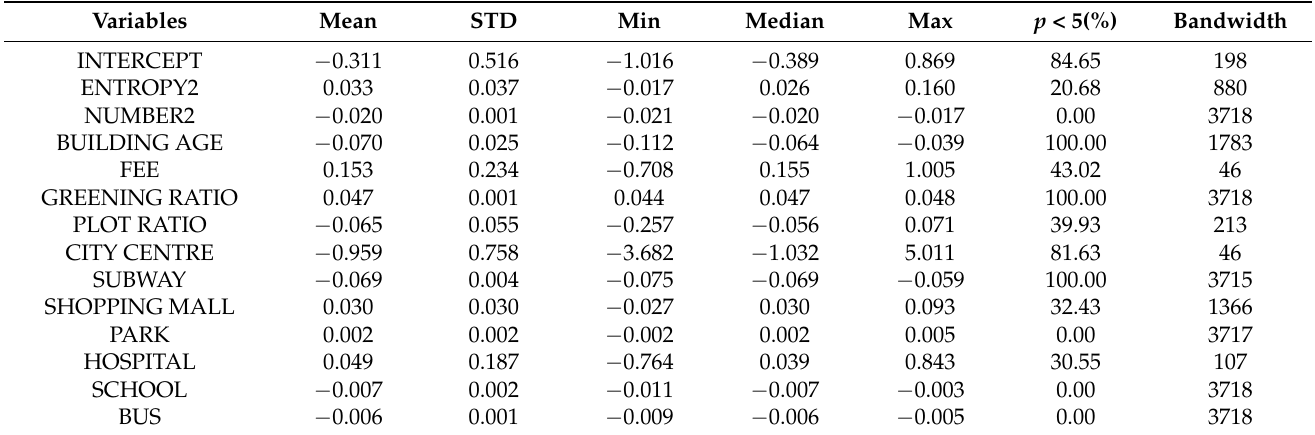
Table 5. MGWR model results of Model 2.